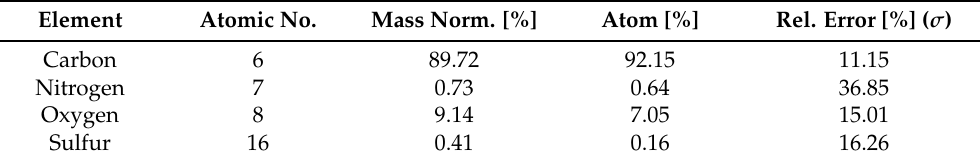
Table 1. Results of the EDX elemental composition analysis of the graphene sponge studied in this work. Here we show the element concentration in mass normalized [%] and atom [%] while in the 5th column the relative error at the one σ level is reported.